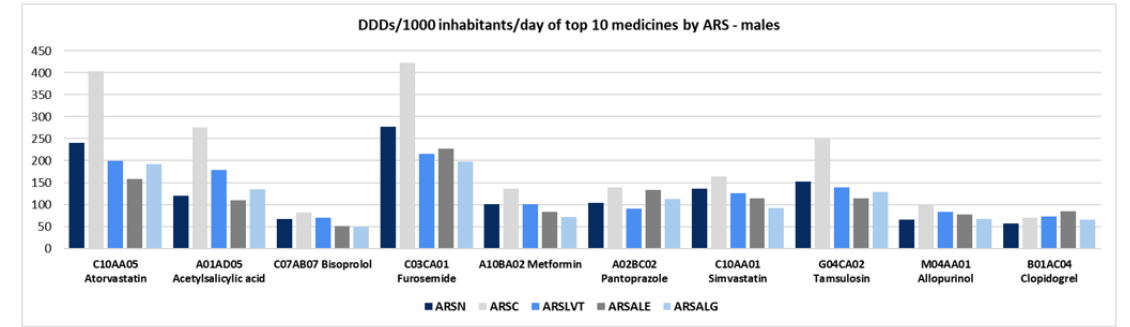
Figure 2. Defined daily dose (DDD) per 1000 inhabitants per day in top-10 level 5 ATCs by health administrative region (ARS) in males. Legend: ARS — North (ARSN), Centre (ARSC), Lisbon-Tejo Valley (ARSLVT), Alentejo (ARSALE), Algarve (ARSALG).